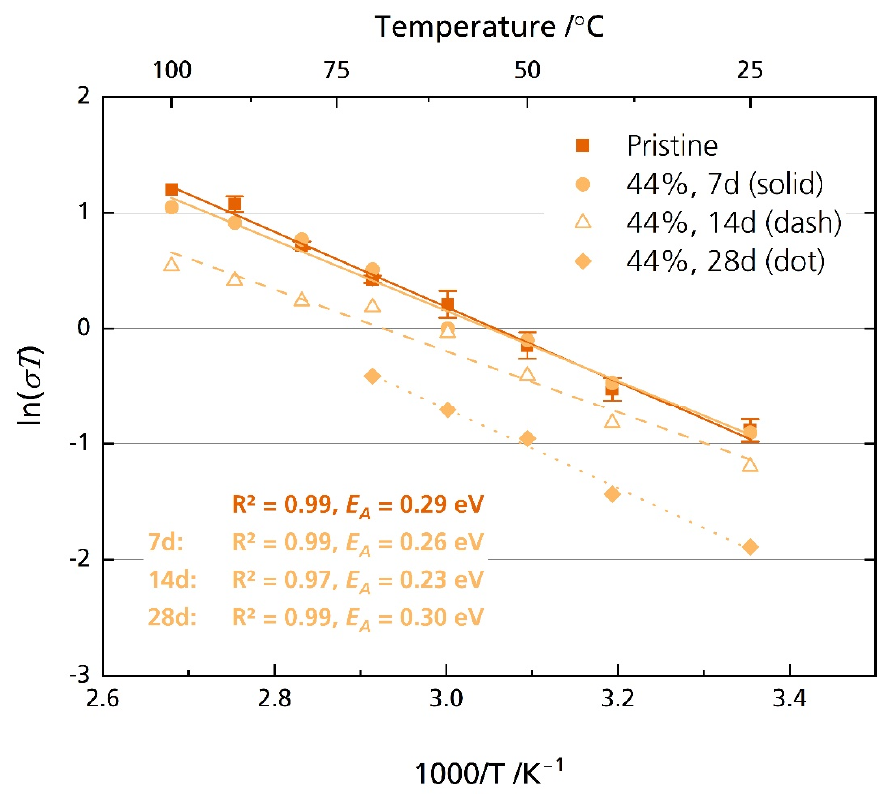
Figure 9. Arrhenius plot of the pristine disks and the disks stored for 7, 14 and 28 days in 44% r.h. The disks were polished with corundum sandpaper before storage but not before measurement. The error bars represent standard deviations.